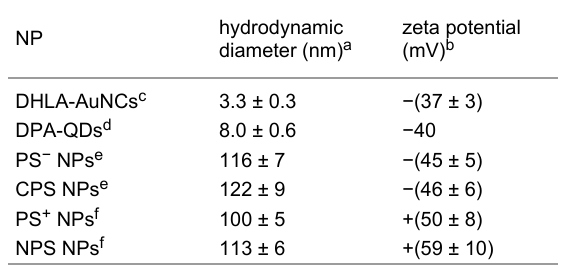
Table 1: Size and surface charge characterization of NPs employed in this